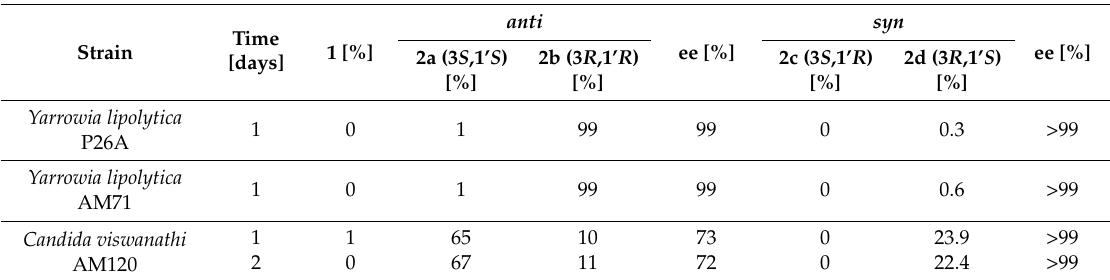
Table 4. The biotransformation of α -acetylbutyrolactone 1 in buffer solution (pH = 7) with 1% of glucose (in % according to